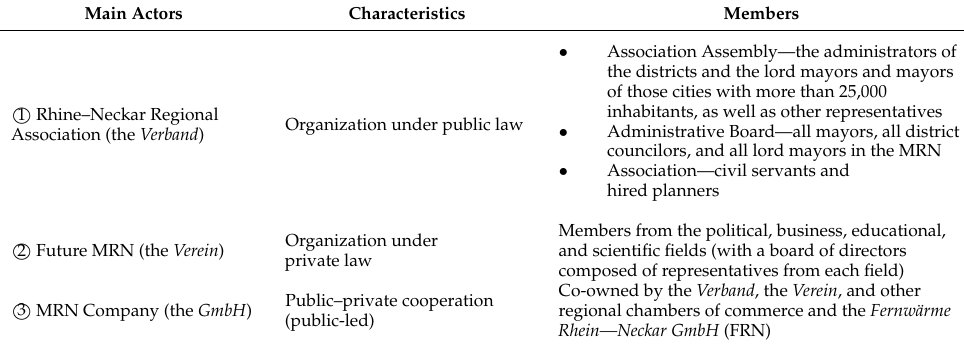
Table 2. Key actors in governing the MRN and their characteristics and